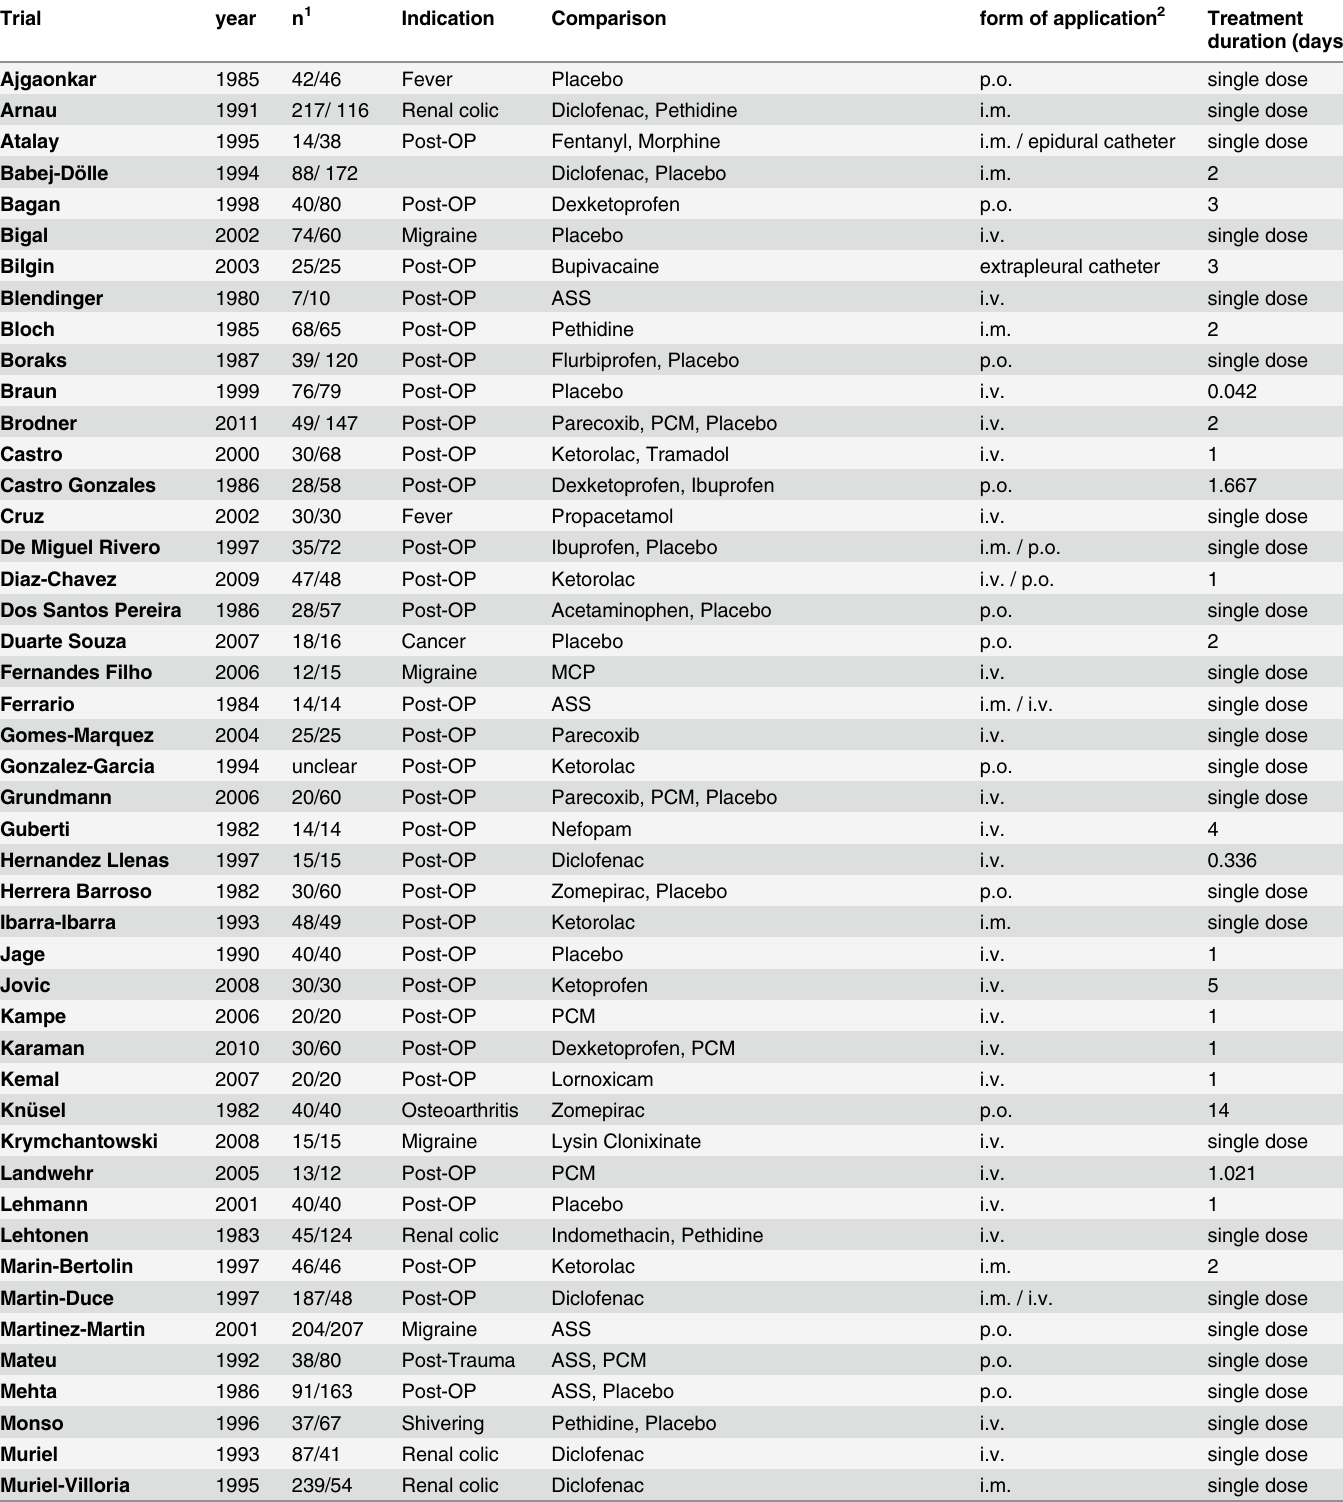
Table 1. Clinical characteristics of the